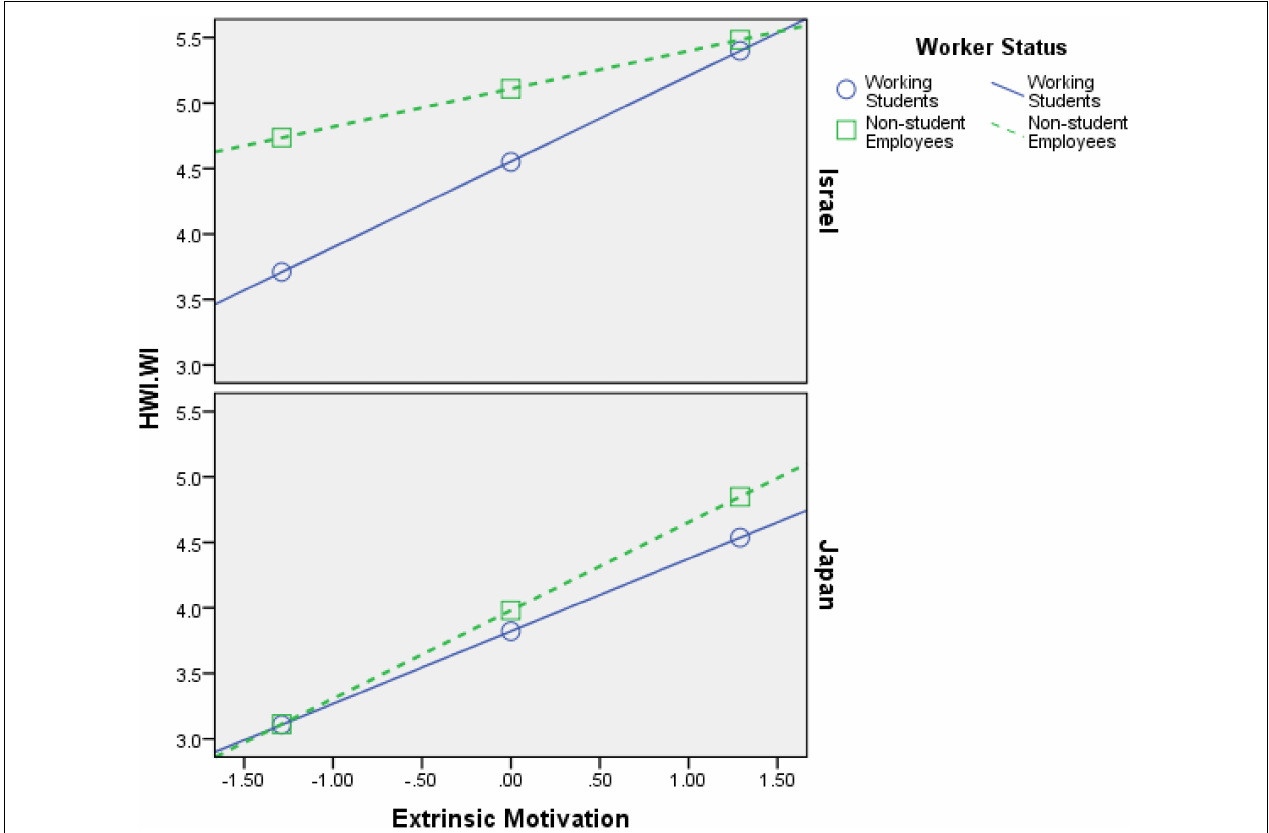
FIGURE 5 | Interaction effects of Extrinsic Motivation × Worker’s Status × Country in predicting HWI-WI. Notes . HWI-WI = work intensity dimension of heavy work